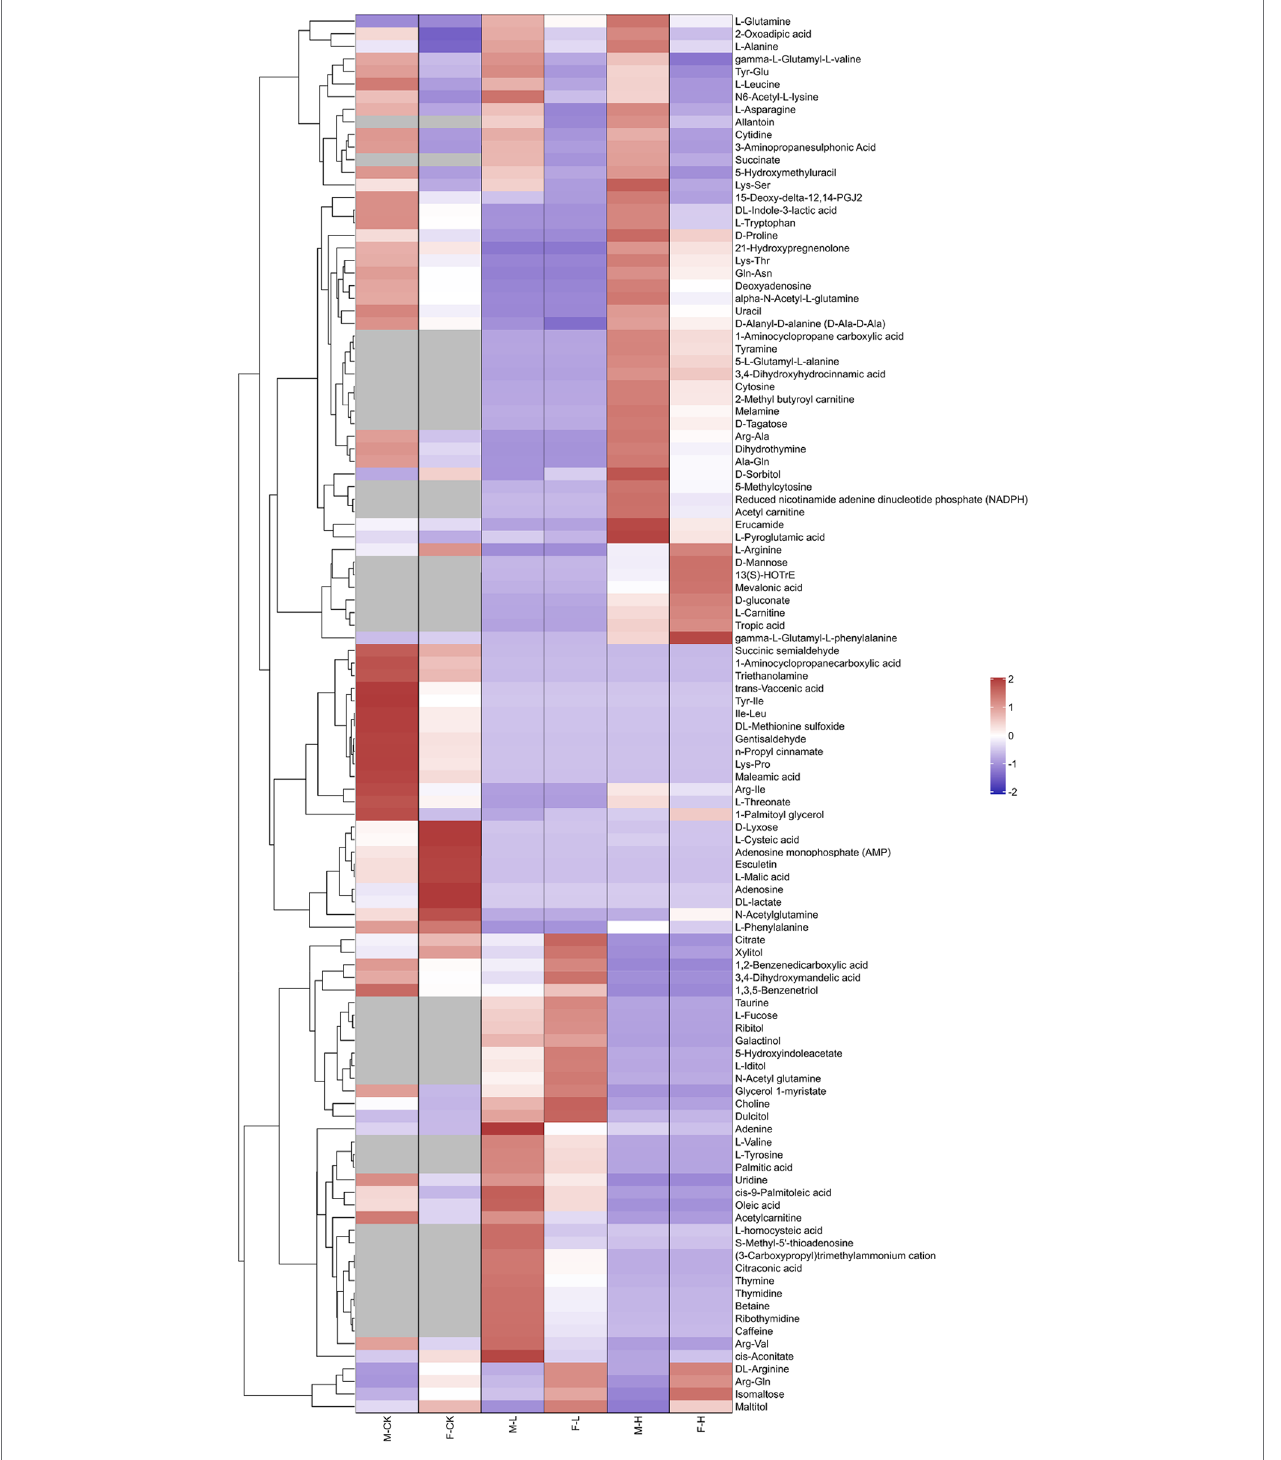
FIGURE 4 | Clustering analysis of differential metabolites of male and female Sargassum thunbergii macroalgae under different UV-B radiation intensities. Rows and columns represent metabolites and treatment groups, respectively. The red color indicates a high abundance of a metabolite, whereas the blue color represents a low relative abundance of a metabolite. The abscissa represents samples and the ordinate represents differential metabolites and M-CK means: the control group of males; M-L means: males under low UV-B radiation conditions; M-H means: males under high UV-B radiation conditions; F-CK means: the control group of females; F-L means: females under low UV-B radiation conditions; and F-H means: females under high UV-B radiation conditions. Red means: males were higher than that of females. Blue means: females were higher than that of